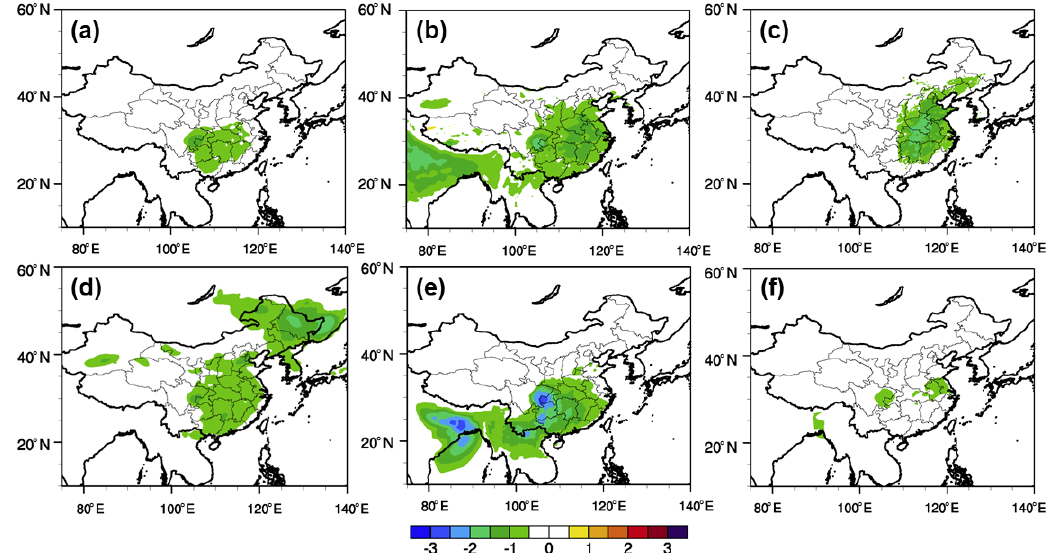
Figure 3. Monthly (January 2010) mean changes in temperature at 2m (T2, ◦ C) due to aerosol radiative effects from M1 (a) , M2 (b) , M4 (c) , M5 (d) , M6 (e) , and M7 (f) (M1: Pusan National University; M2: University of Iowa; M4: NASA; M5: Institute of Atmospheric Physics; M6: Nanjing University; M7: University of Tennessee; Gao et al., 2018a). Table 4. Mean aerosol (January 2010) direct radiative forcing (Wm − 2 ) and changes in T2 ( ◦ C), Q2 (gkg − 1 ), WS10 (0.1ms − 1 ), and PM 2 . 5 (µgm − 3 ) for Beijing and the Beijing–Tianjin–Hebei (BTH) region averaged over 17–19 January 2010 (areas marked in Fig. S1). Beijing M1 PNU M2 UIOWA M4 NASA M5 IAP ADRF TOA ADRF